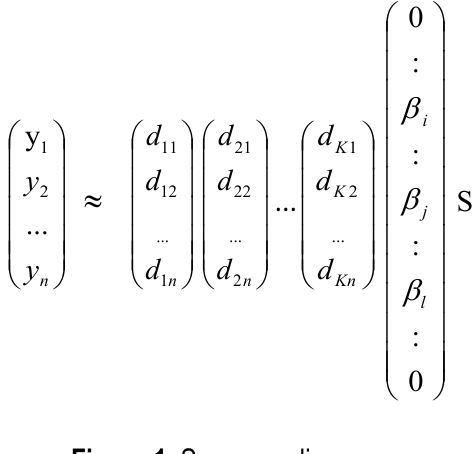
Figure 1. Sparse